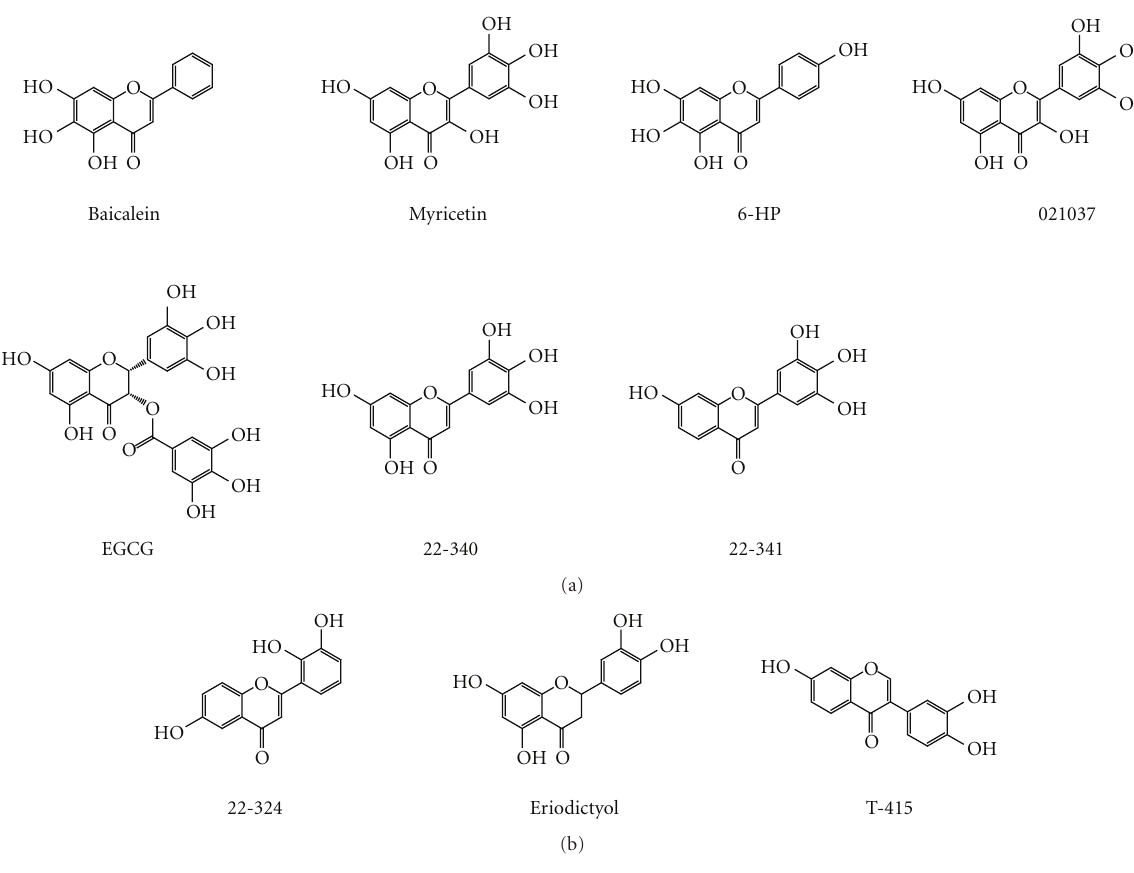
Figure 13: Structures of the strong inhibitory flavonoids of α -synuclein fibrillation, with three (a) and two (b) vicinal hydroxyl groups.